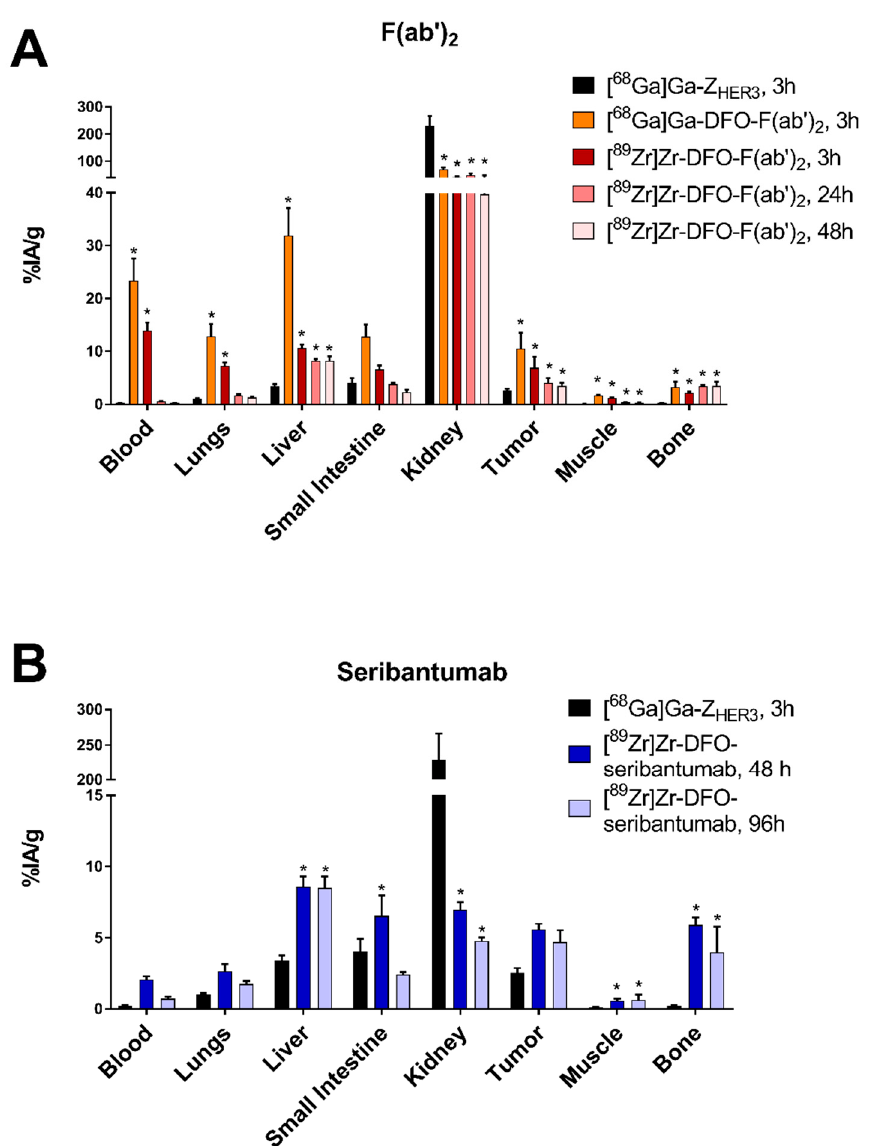
Figure 4. Biodistribution of ( A ) [ 68 Ga]Ga-DFO-seribantumab-F(ab’) 2 , [ 89 Zr]Zr-DFO-seribantumab-F(ab’) 2 , and ( B ) [ 89 Zr]Zr-DFO-seribantumab in balb/c nu/nu mice with HER3-expressing BxPC-3 xenografts. Biodistributions of [ 68 Ga]Ga-Z HER3 3 h pi were added to the respective graphs for comparison. Data are presented as the average of n = 4–6 animals with SD. * Indicates a statistically significant difference ( p < 0.05) with [ 68 Ga]Ga-Z HER3 . Numerical data as well as detailed information on statistically significant differences between groups can be found in Supplementary Materials, Tables S1 and S2.